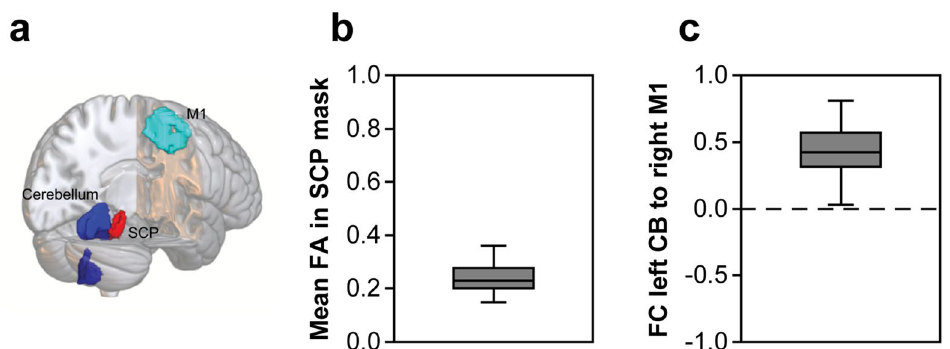
Figure 5. ( a ) Overview of the regions of interest (ROIs) for MRI analysis visualized with MRIcroGL (https :// www.mccau sland cente r.sc.edu/mricr ogl/). For rsMRI: blue, motor part of the left cerebellum (CB); light blue, right primary motor cortex (M1). For DWI: red, bilateral superior cerebellar peduncle (SCP). ( b ) Mean FA in the SCP mask, ( c ) Functional connectivity (FC) between left CB and right M1. Box plots depict median (solid vertical line), box bounds (upper to lower quartile), whisker (range within 1.5 interquartile